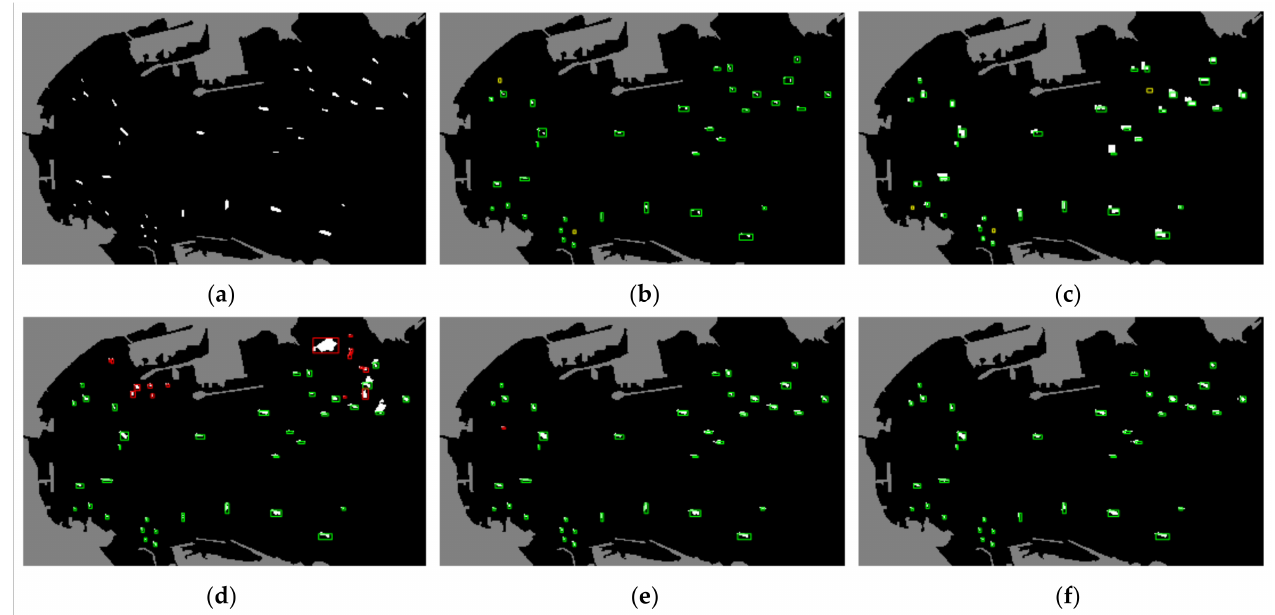
Figure 9. Detection results from Radarsat-2 area II. ( a ) Ground-truth image. ( b ) SO-CFAR. ( c ) SP. ( d ) T3 + SVM. ( e ) PCP + SVM. ( f ) Proposed method. (Green: correct detection, yellow: missed detection, red: false alarm).